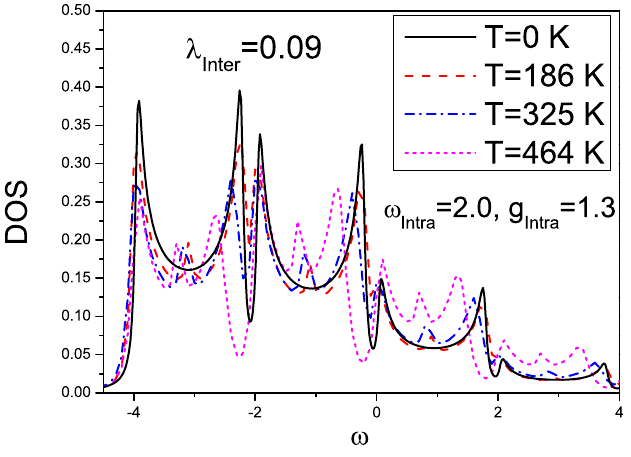
Figure 6. The DOS (in units of 1 /t ) as a function of the frequency (in units of t/ ¯ h ) for different temperatures, T, at λ units of t , with t = 80